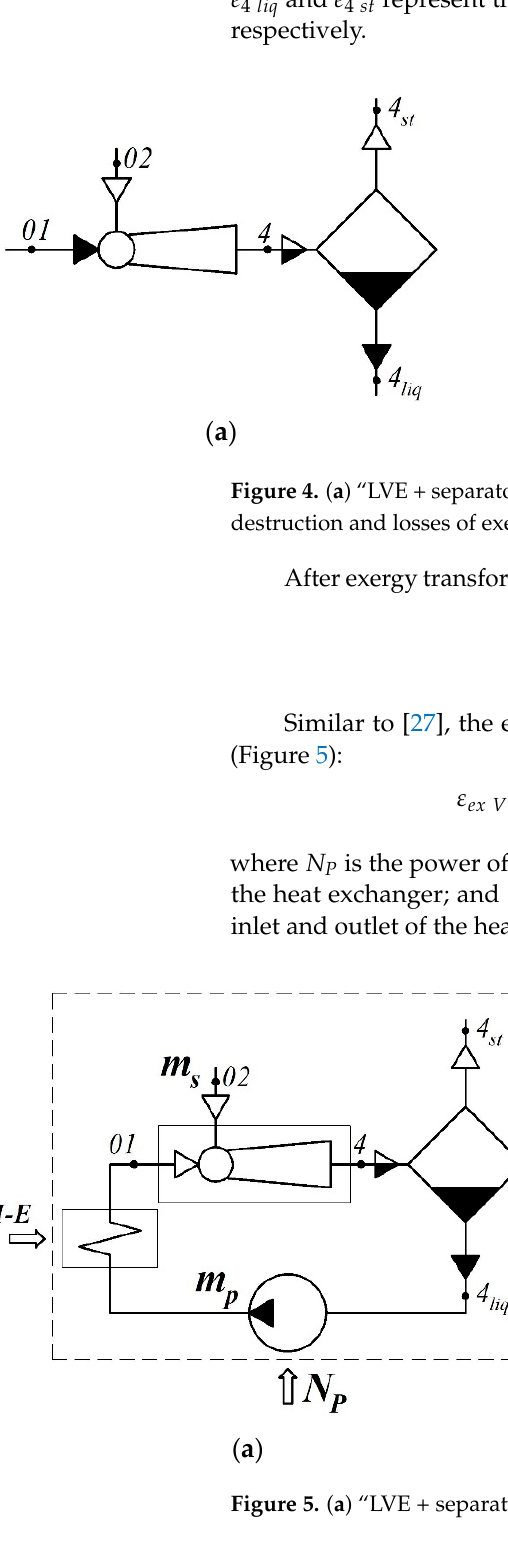
Figure 5. ( a ) “LVE + separator” system diagram and ( b ) scheme of exergy transformations.